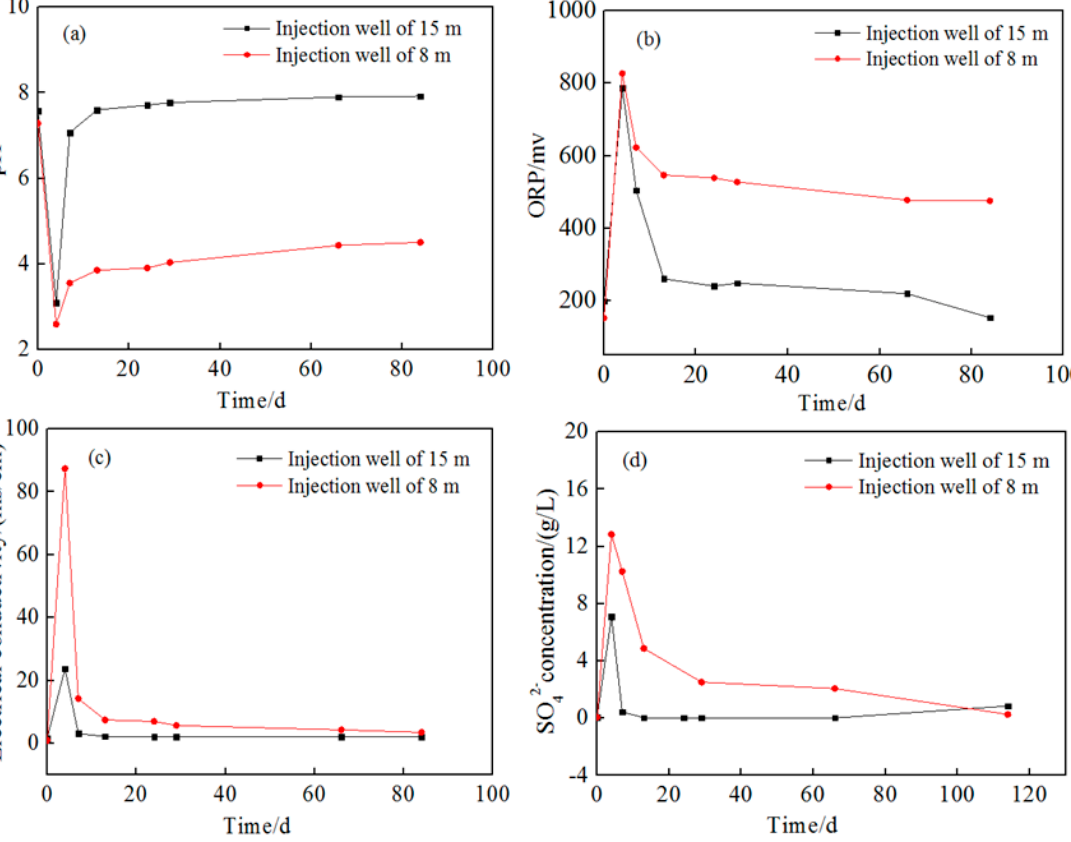
Figure 6. Change of geochemical parameters at injection wells. ( a ) pH; ( b ) oxidation–reduction potential (ORP); ( c ) electrical conductivity; ( d ) the concentration of SO 42 − .